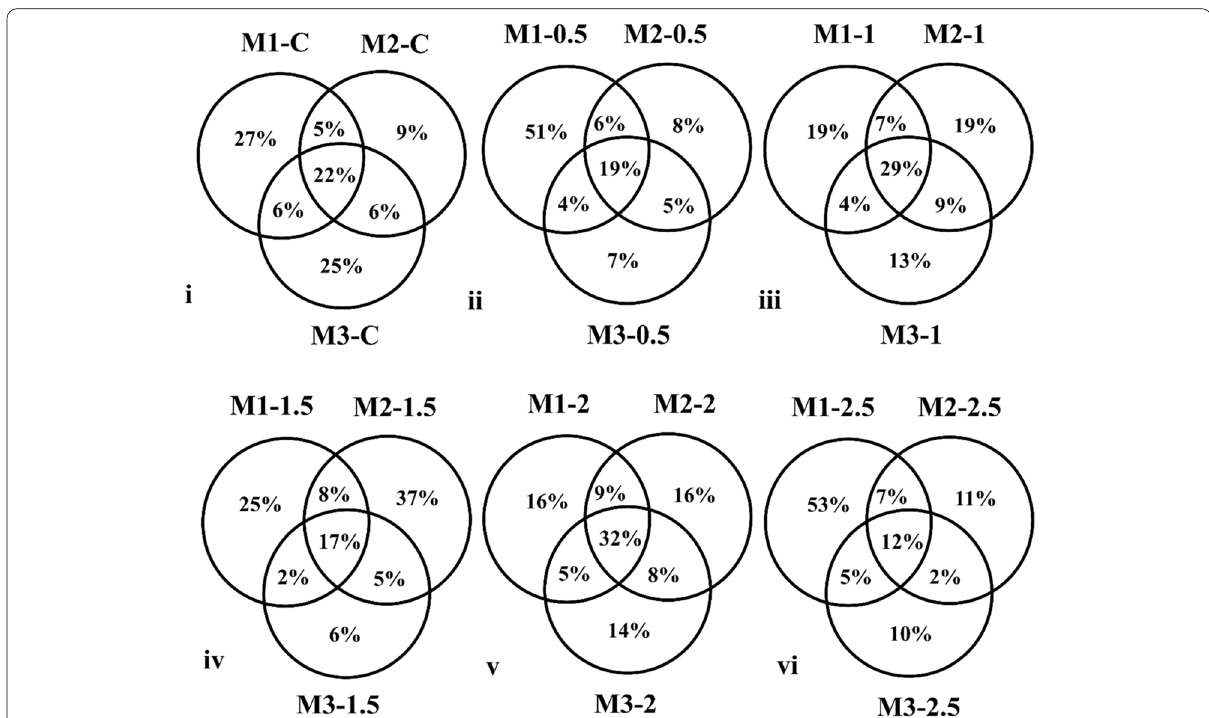
Fig. 6 Venn diagram illustrates the percentage of month-wise shared and unique OTUs present in the non-amended and sclerotia-amended soil samples in rice-rapeseed rotation field soil amended with different doses of R. solani sclerotia as obtained from 16S rRNA sequencing. M1, M2, and M3 represent 1 st month, 2 nd month, and 3 rd month while C shows the non-amended samples. Moreover, 0.5, 1, 1.5, 2 and 2.5 denotes the different dose of sclerotia in gram amended in